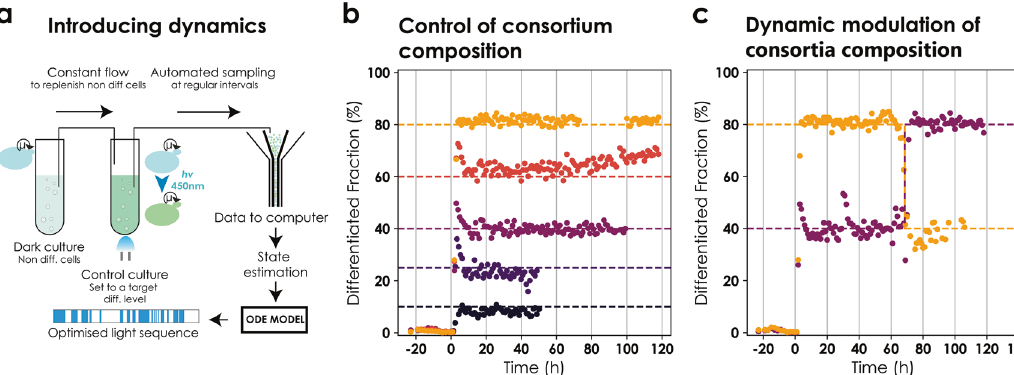
Fig. 3 Dynamic control of population composition in a microbial consortium. a Setup for two reactor control. Cells harbouring the original differentiation system were continuously cultured at fi xed but different cell densities in two reactors simultaneously. The fi rst reactor was kept in the dark as a reservoir of non-differentiated cells. The output of this vessel was connected to the second ‘ control ’ reactor. The control culture was set to a target level of differentiation and continuously monitored via automated fl ow cytometry measurements that were analysed online. The system state was estimated from analysed data and sent to the model predictive control (MPC) module. The MPC module provided an optimized light sequence to maintain the culture at the desired set point (Supplementary Note 5). b Control of consortium composition. Cultures were targeted to 10 – 80% differentiation. Control started at t = 0. Circles signify differentiated fractions. Each colour corresponds to a different control experiment and the dashed line re fl ects the target set point. Note that the fi gure is composed of independent experiments of different lengths. Data were removed when the OD, either in the reservoir or the control reactor, could not be maintained at the desired target. Light signals are provided in Supplementary Fig. 17. c Bidirectional control of consortium composition. Cultures were targeted to 40 and 80% differentiation. Data are represented as in ( b ). The target was changed at t = 60 h to 80% and 40%,